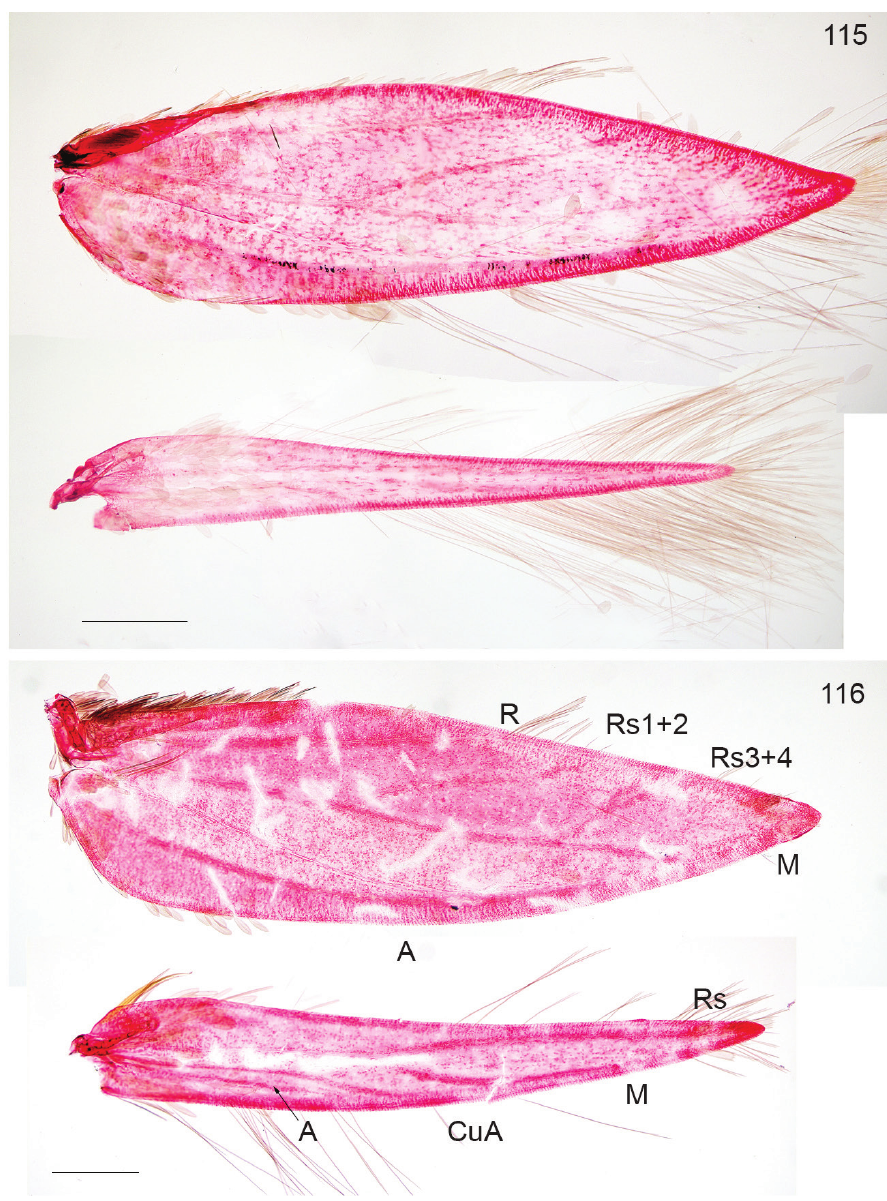
Figures 115–116. Hesperolyra gen. n., venation. 115 H. diskusi , male paratype, slide EvN4501 116 H. saopaulensis , female, veins labelled, slide EvN4505. Scale bars: 200 µm.